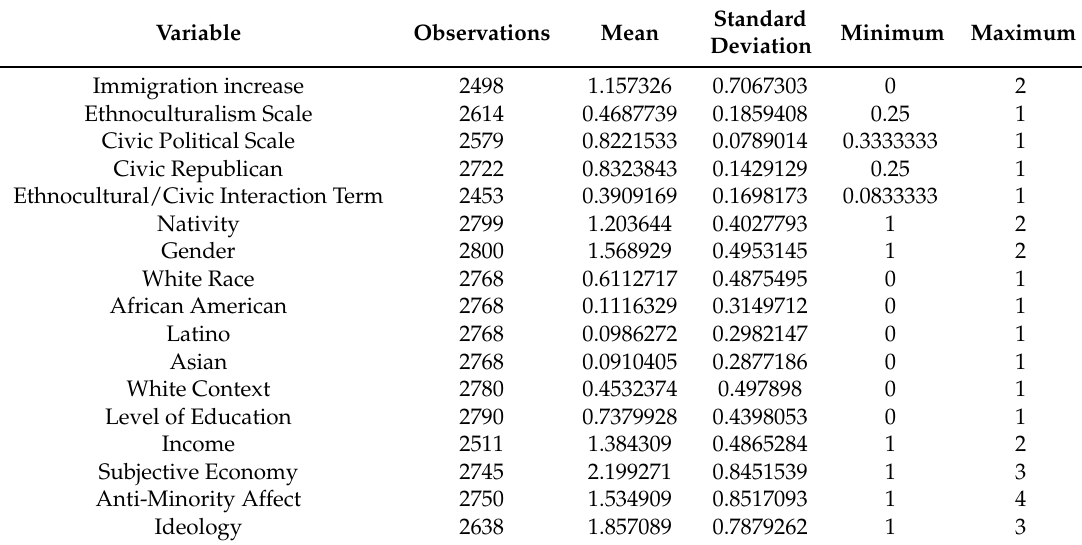
Table 2. Summary